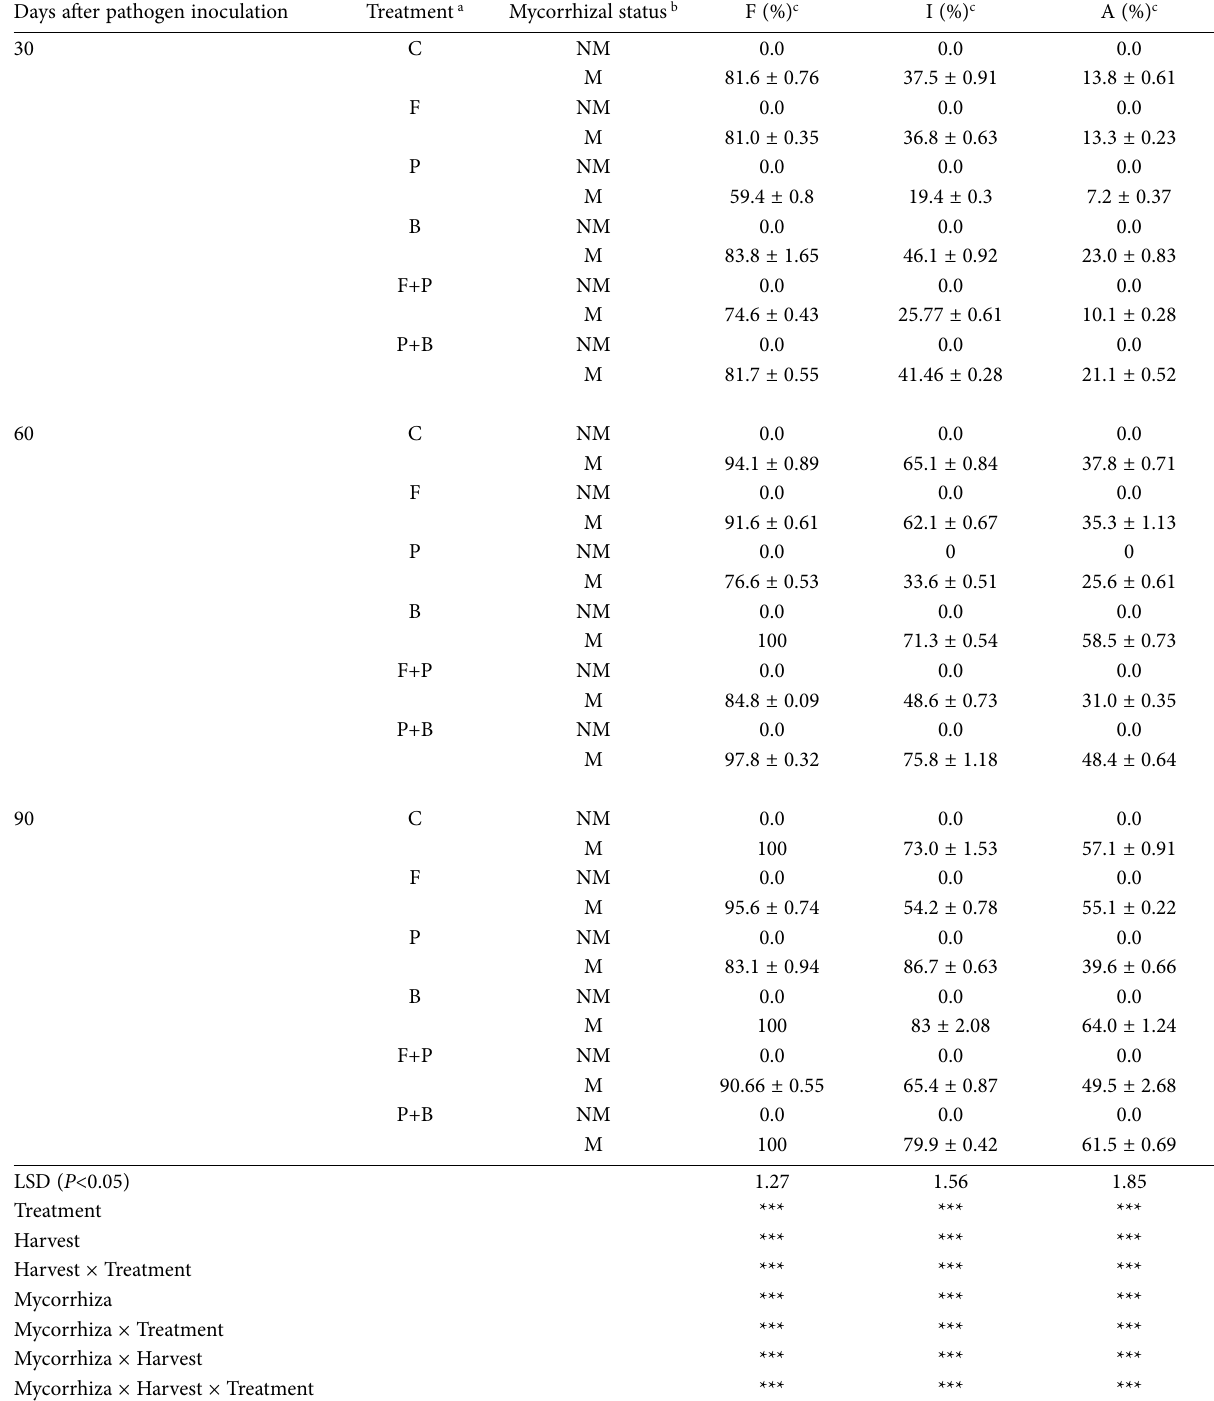
Table 4. Mean proportions (± standard error) of mycorrhizal colonization in garlic plant roots at intervals after different treatments were